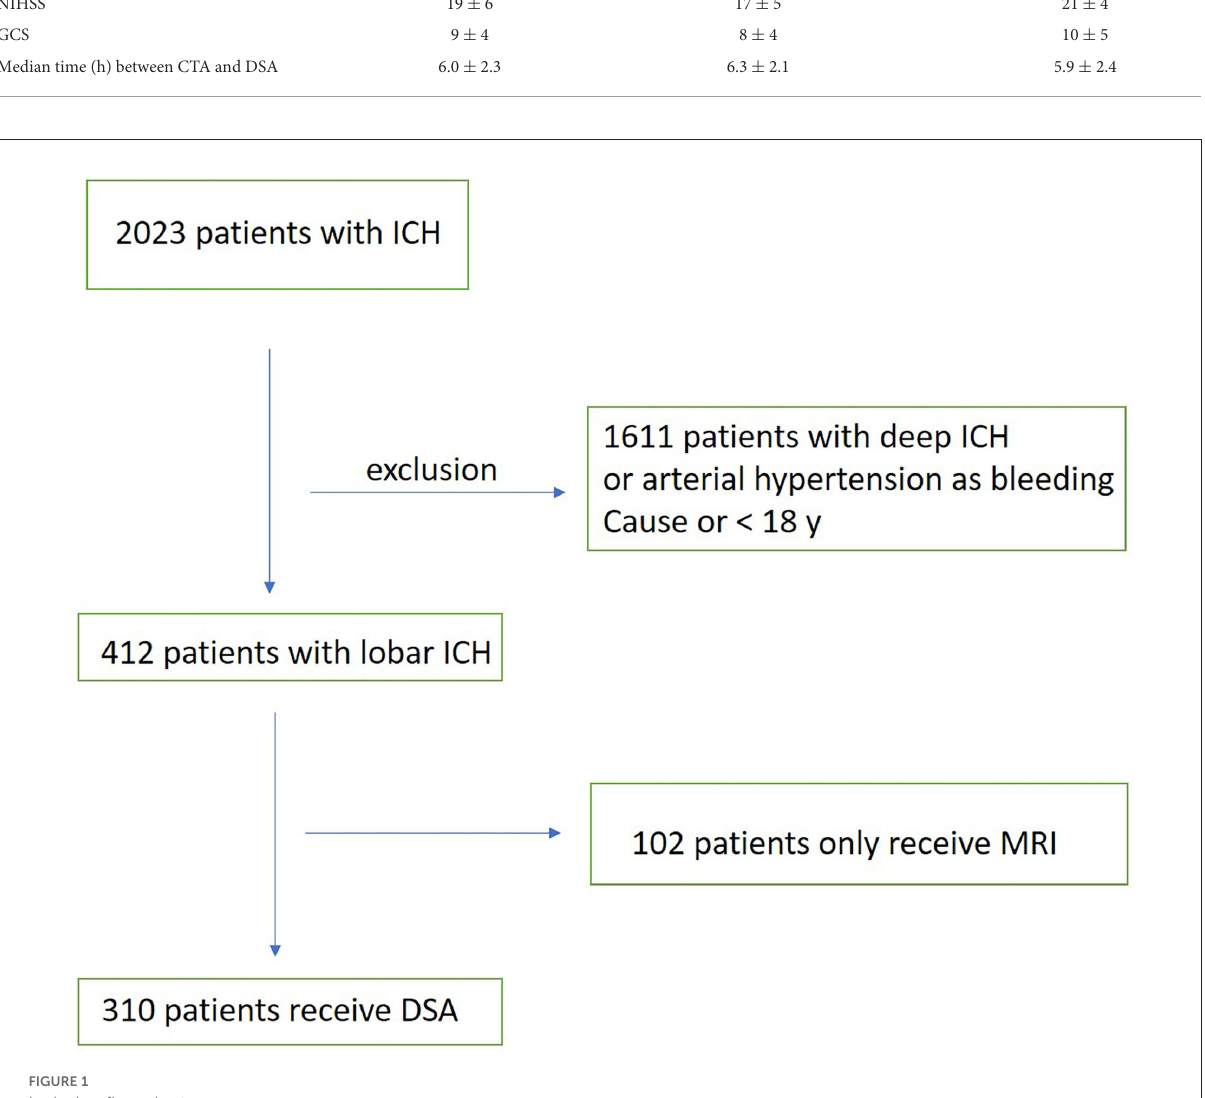
patients had vasculitis (3%), and 23 patients had dural arterio- venous fistulas (dural AV fistula) (6%) (Table 2). In total, five DSA-negative cases were found to be related to tumors on MRI. The positive